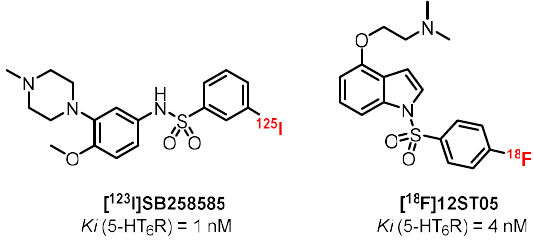
Figure 15. [ 125 I]SB258585 and [ 18 F]12ST05 .